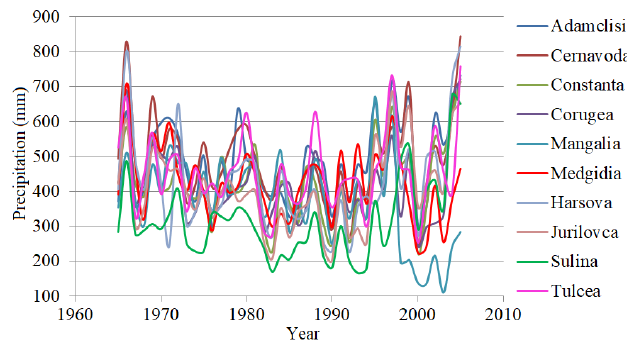
Figure 7. The annual precipitation series.